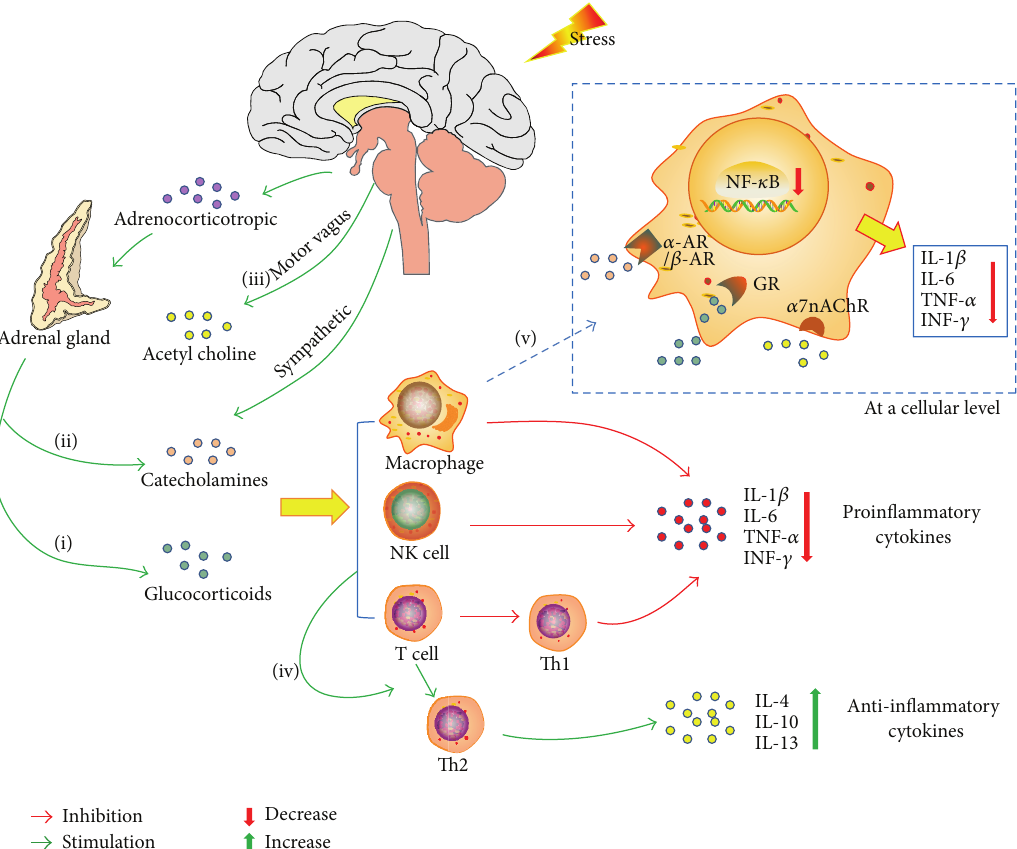
Figure 1: The mechanism of chronic stress acting on inflammatory cytokines. The chronic stress activates the (i) HPA and (ii) SAM axis and, respectively, secretes glucocorticoids and catecholamines hormones, which in turn act on the receptors on the surface or in the cytoplasm of the immune cells, (iii) and, meanwhile, motor vagus fiber also secretes catecholamines and ultimately inhibits the proinflammatory cytokines while promoting the anti-inflammatory cytokines. (iv) Both the glucocorticoids and catecholamines promote the Th1 to Th2 shift, including inhibiting the IL-12 secretion and further boosting the shift. (v) At the cellular level, the signal transduction level, stress hormones inhibit the inflammation related pathways, including NF- 𝜅 B, and further inhibit the proinflammatory cytokines